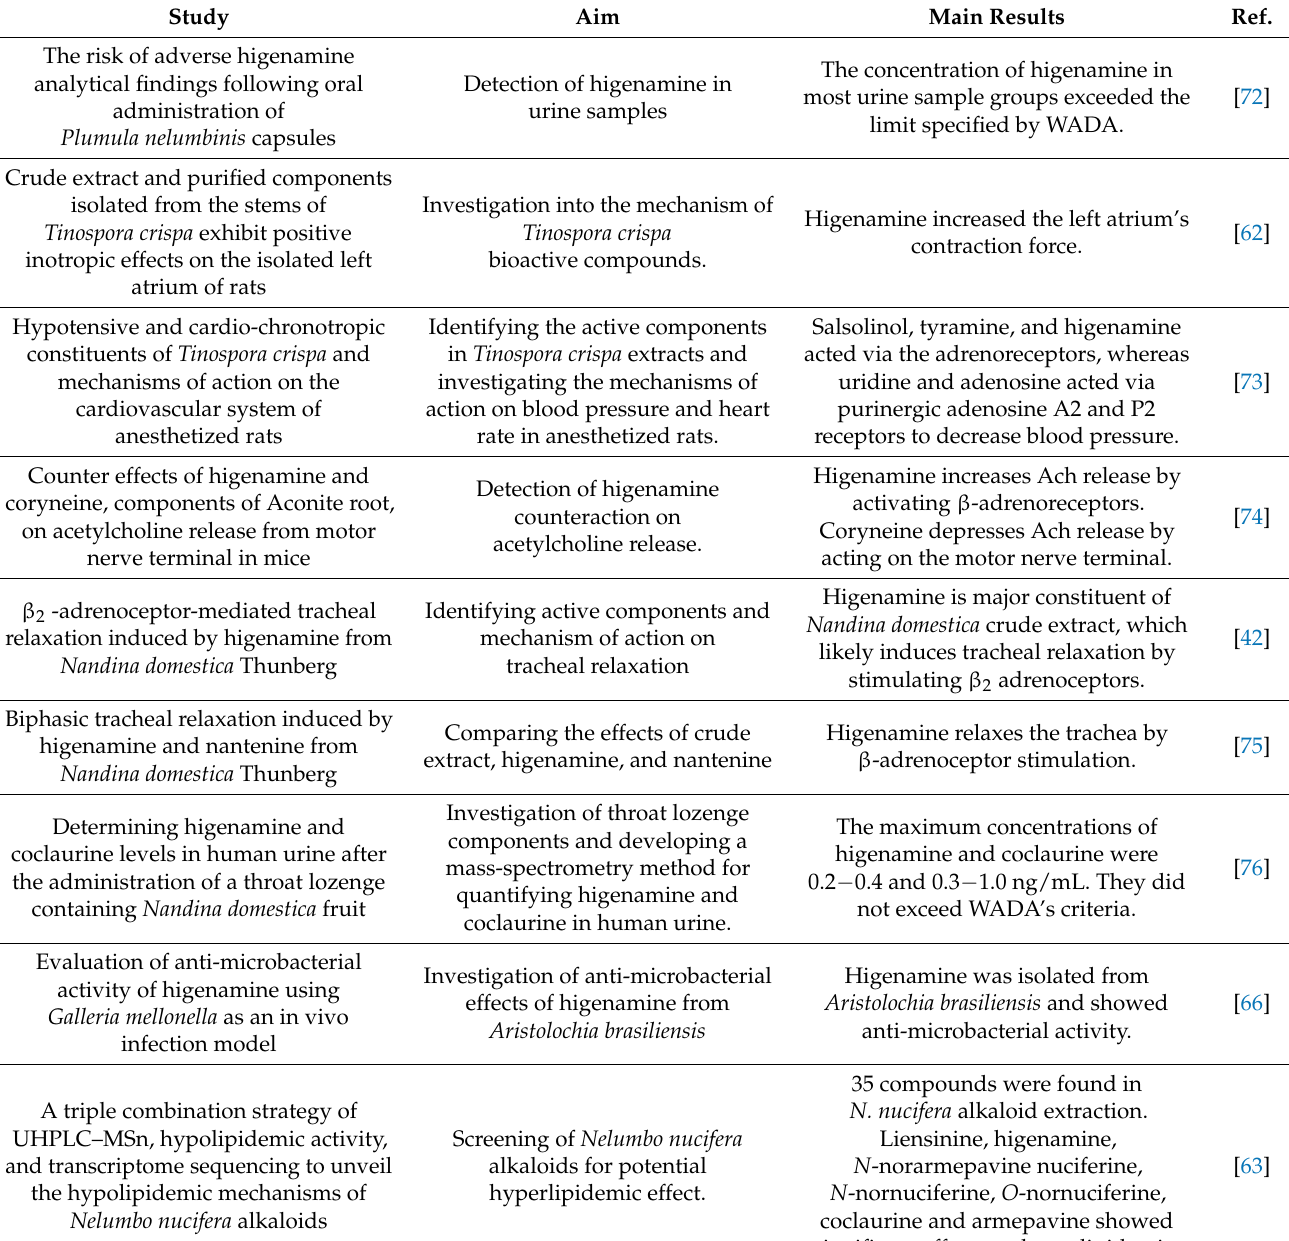
Table 2. Studies of higenamine in human/mammals in various